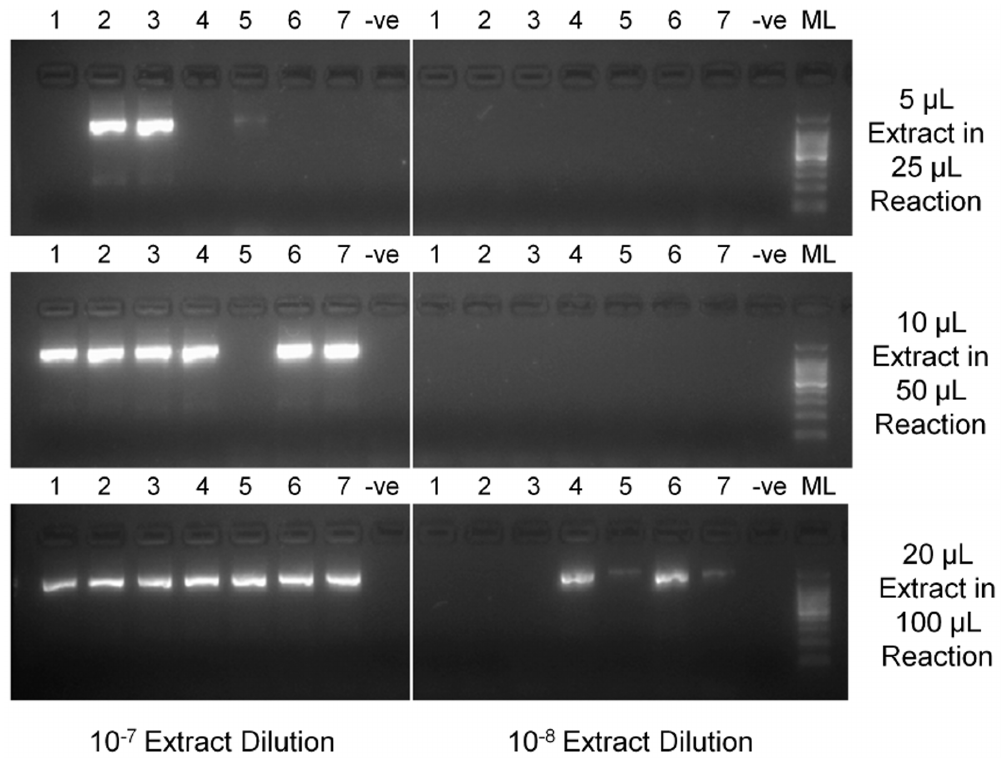
Figure 1. Gel image of amplicons produced using varying extract volumes. Annotated gel image of round two PCR products from nested PCR using varying volumes of diluted DNA extracts in the preceding round one reaction. The products for all seven isolate extracts at the highest two dilutions are shown. Wells to the left of the image contain 10 2 7 dilution extracts (600 ag/ m L) and wells adjacent to the molecular weight ladder contain 10 2 8 dilution extracts (60 ag/ m L). The extract/reaction volumes ( m L) are indicated on the right of the image. Extract numbers refer to the order in which the isolates are listed in Table S1. ML=Molecular ladder.